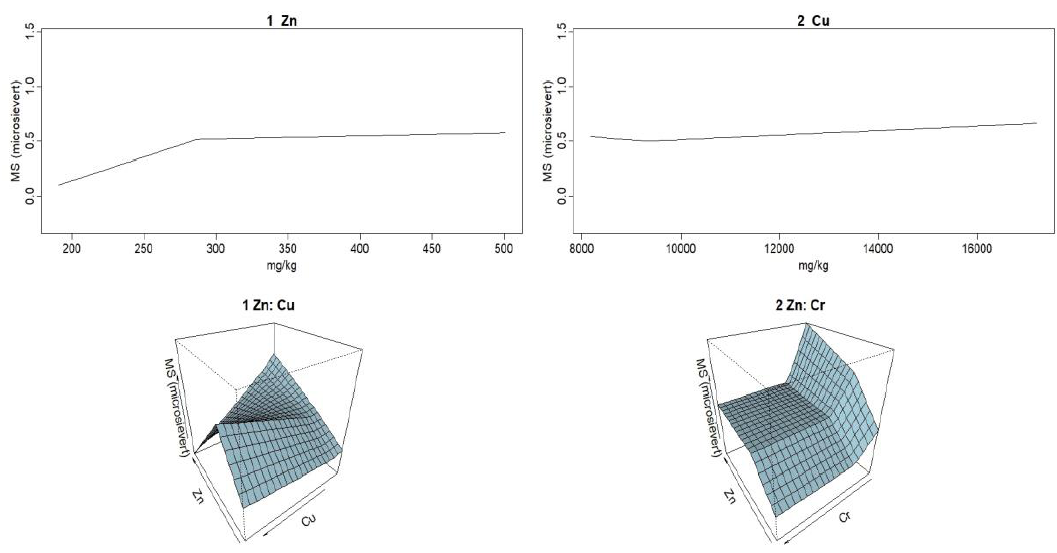
Figure 5. Relationship between metal concentration and magnetic susceptibility.